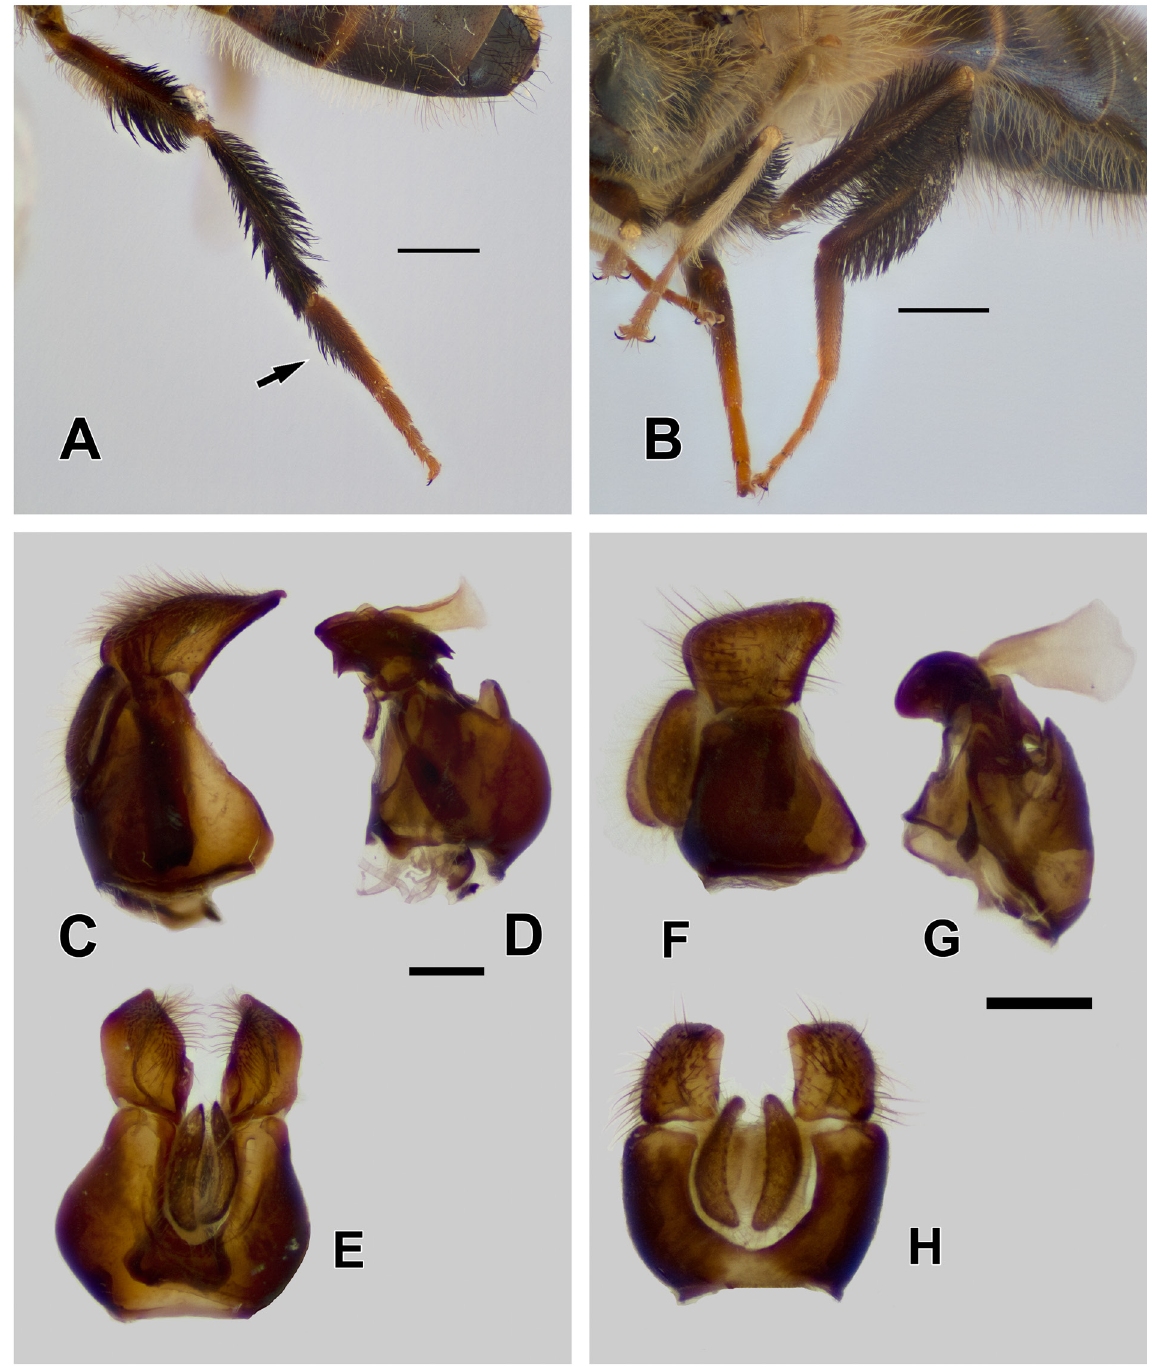
Fig. 5. A . Afrosyrphus varipes Curran, 1927, ♀ (ZFMK-DIP-00015969), hind leg. Arrow indicates the long black pile on the hind first tarsomere (= metabasitarsomere). B . Afrosyrphus schmuttereri sp. nov., paratype, ♂ (ZFMK-DIP-00019829), hind leg. C–E . Afrosyrphus varipes , ♂ (ZFMK-DIP-00015968), genitalia. C . Epandrium and surstyli, lateral view. D . Hypandrium, postgonites and aedeagus, lateral view. E . Epandrium, cerci and surstyli, dorsal view. F–H . Afrosyrphus schmuttereri sp. nov., paratype, ♂ (ZFMK-DIP-00019829), genitalia. F . Epandrium and surstyli, lateral view. G . Hypandrium, postgonites and aedeagus, lateral view. H . Epandrium, cerci and surstyli, dorsal view. Scale bars: A–B = 1 mm; C–H = 0.25